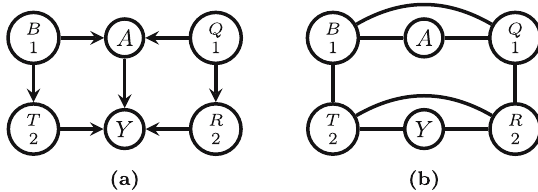
Figure 3: An example of a directed acyclic graph in which the optimal minimum cardinality L N – adjustment set is more e ffi cient than the optimal minimum cost L N – adjustment set: ( a ) (cid:3) and ( b ) 1 (cid:2)